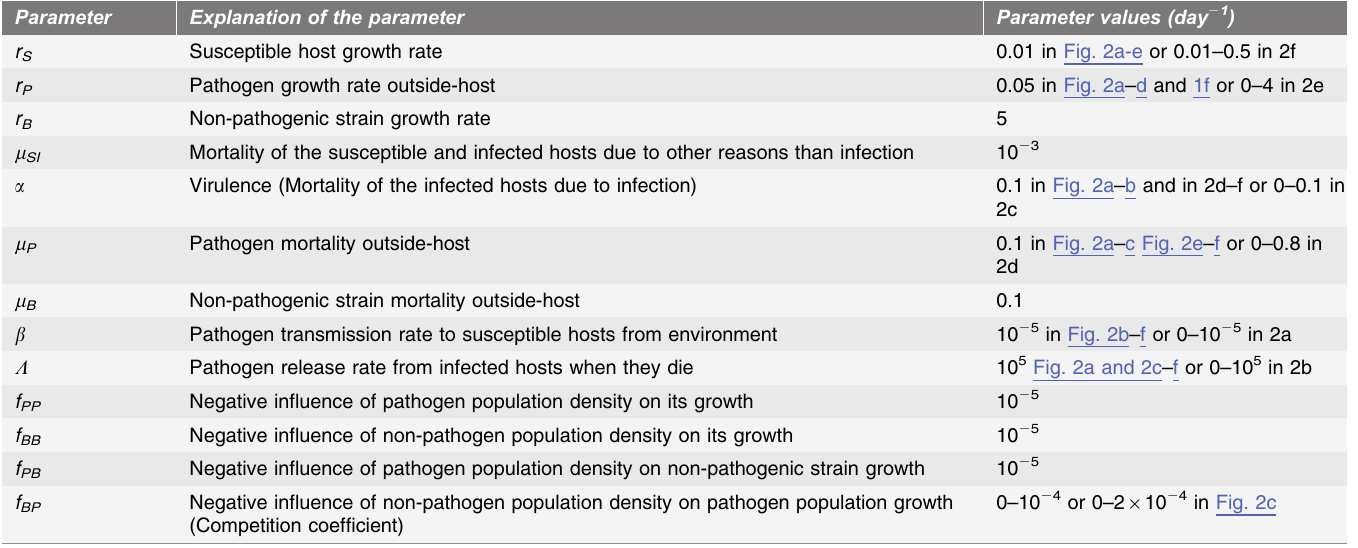
Table 1. Parameter values per time unit (one day) used in the invasion